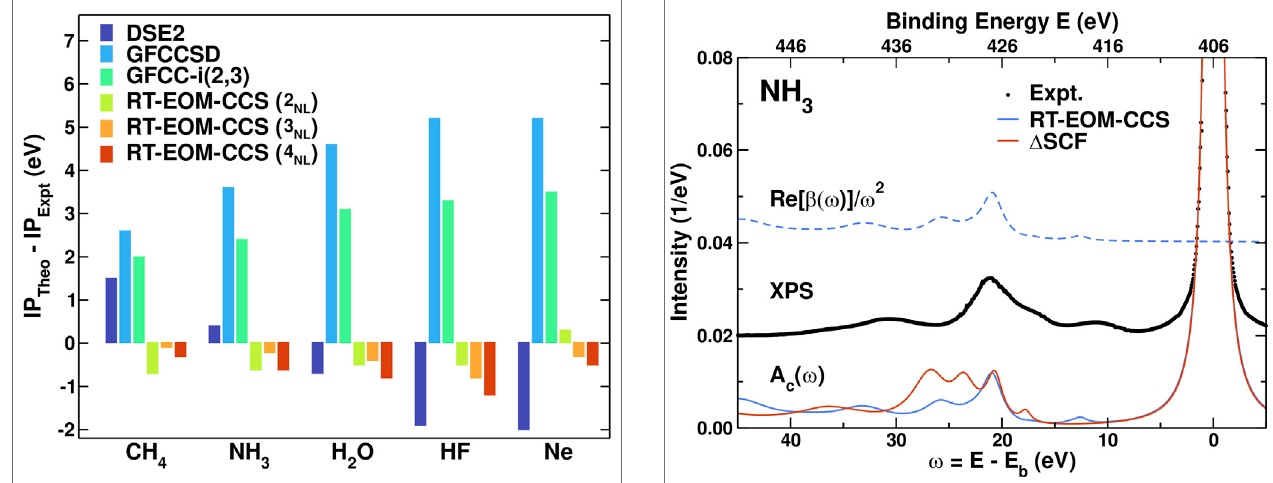
FIGURE 3 | Comparison of the 4 NL RT-EOM-CCS and Δ SCF core spectral functions A c ( ω ) (full lines) and cumulant kernel β ( ω ) (dashed lines, shown only for the RT-EOM-CC method) for the NH 3 molecule, to the experimental XPS (dots) (Sankari et al., 2006). Energies are shows in either absolute binding energy E or versus excitation energy ω (cid:2) E − E b with respecttotheexperimentalcorebindingenergy E b (cid:2) 405.52 eV(Sankarietal., 2006). All the theoretical results were obtained with the aug-cc-pVDZ basis set. The theoretical A c ( ω ) were broadened and include a scissors shift of 3.9